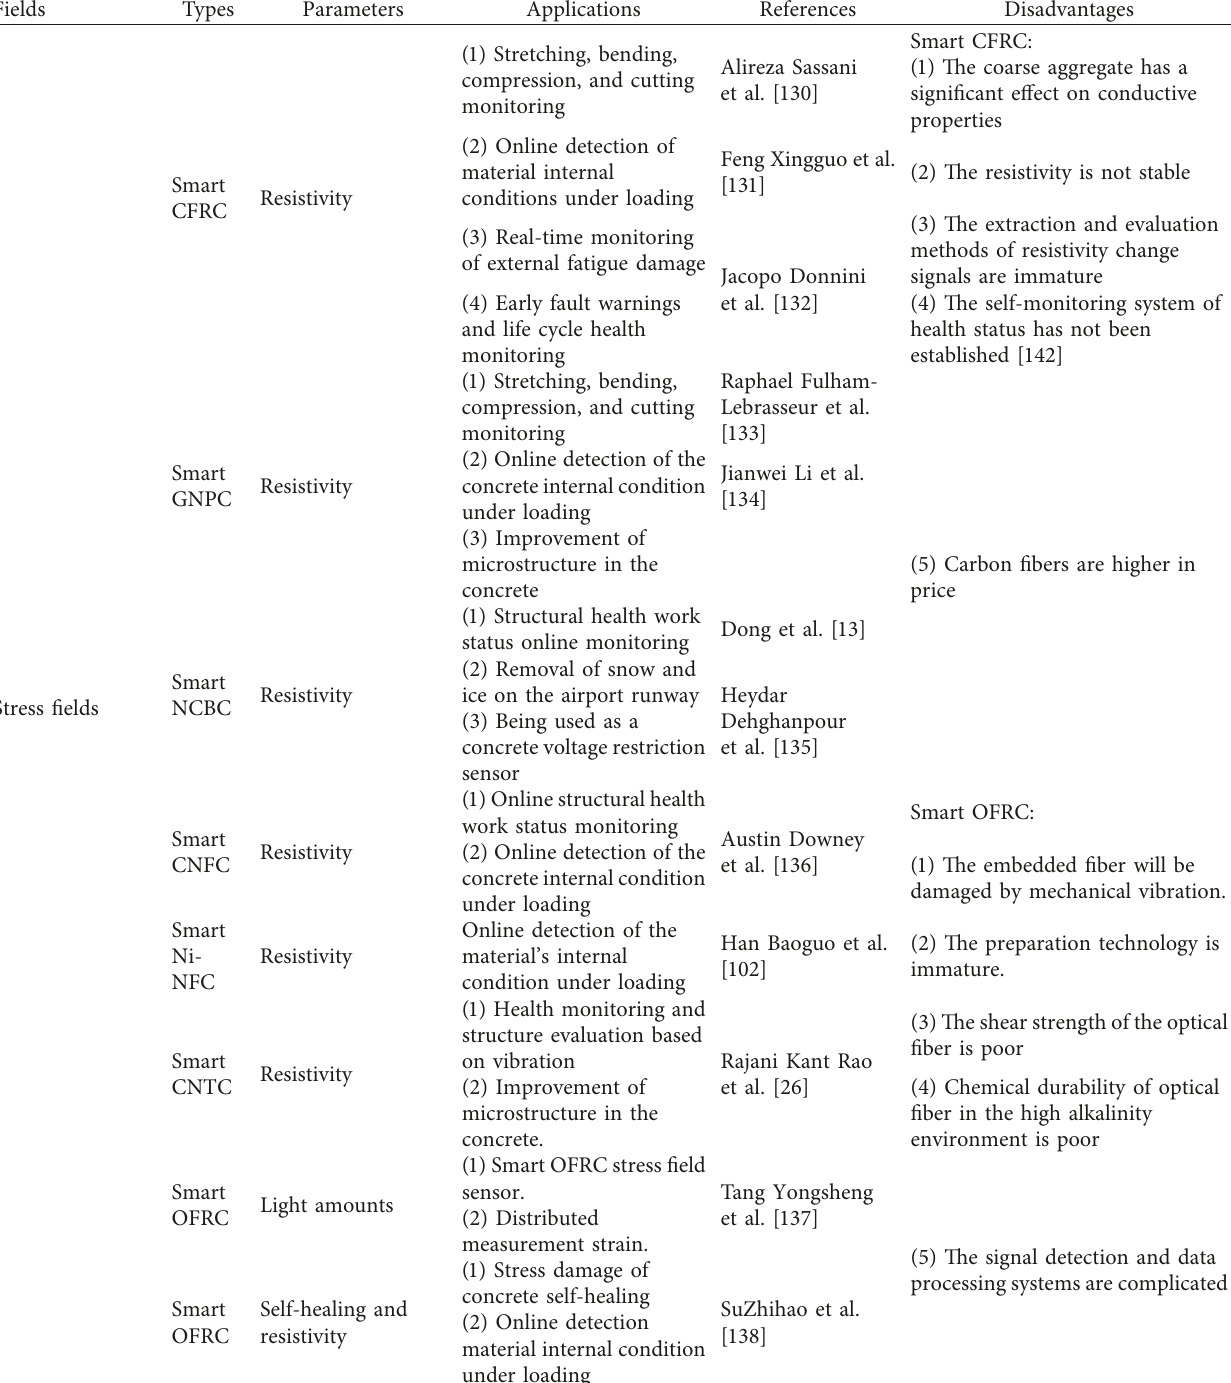
Table 3: Comparison of environmentally intelligent response